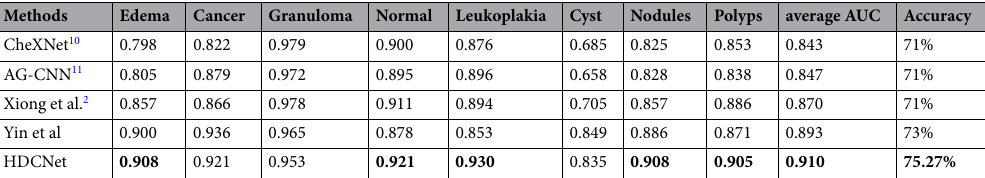
Table 1. The performance evaluation of different methods on the AUC and overall accuracy among all classes, the best results are highlighted in